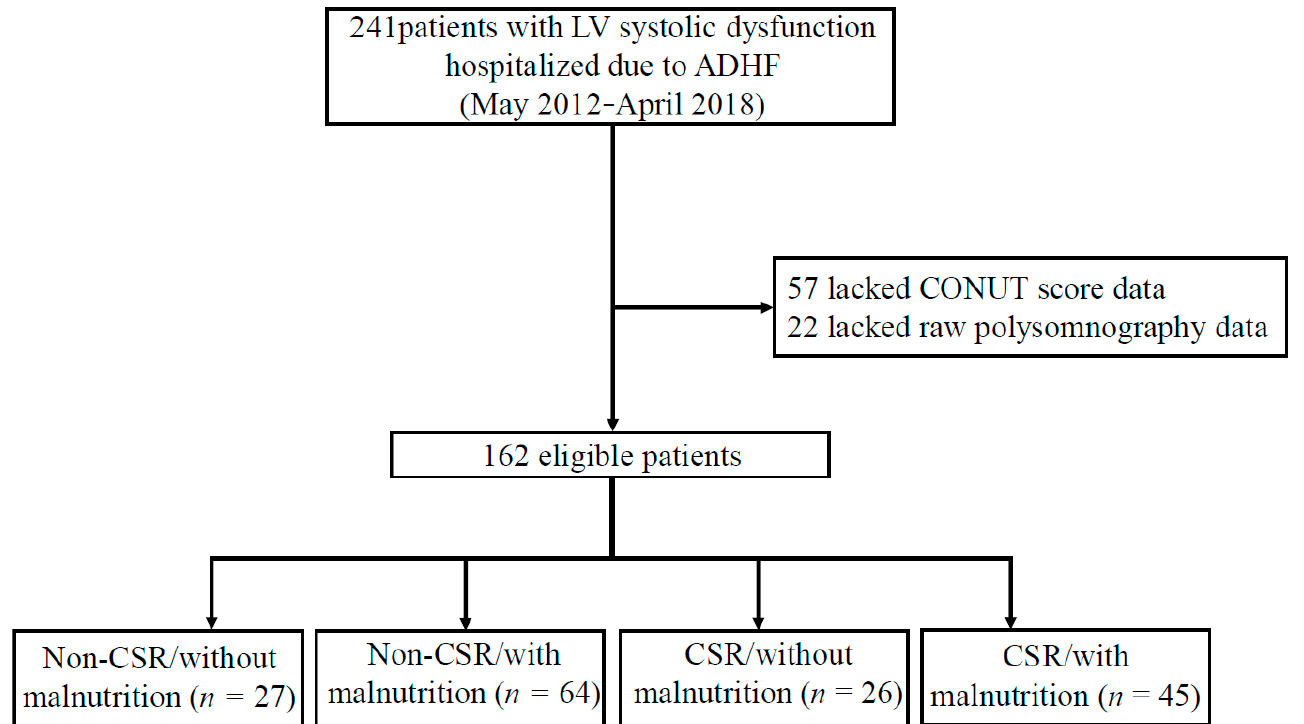
Figure 1. Flow diagram of the study population. From May 2012 to April 2018, 241 patients with LV systolic dysfunction (defined as LVEF < 50% via echocardiography) due to ADHF were hospitalized at Juntendo University Hospital. Among them, 79 patients were excluded for the following reasons: lacked CONUT score data (albumin, total cholesterol) and raw data of polysomnography. Thus, 162 eligible patients were enrolled in the study. Abbreviations: ADHF, acute decompensated heart failure; CSR, Cheyne-stokes respiration; CONUT, controlling nutritional status; LV, left ventricular.